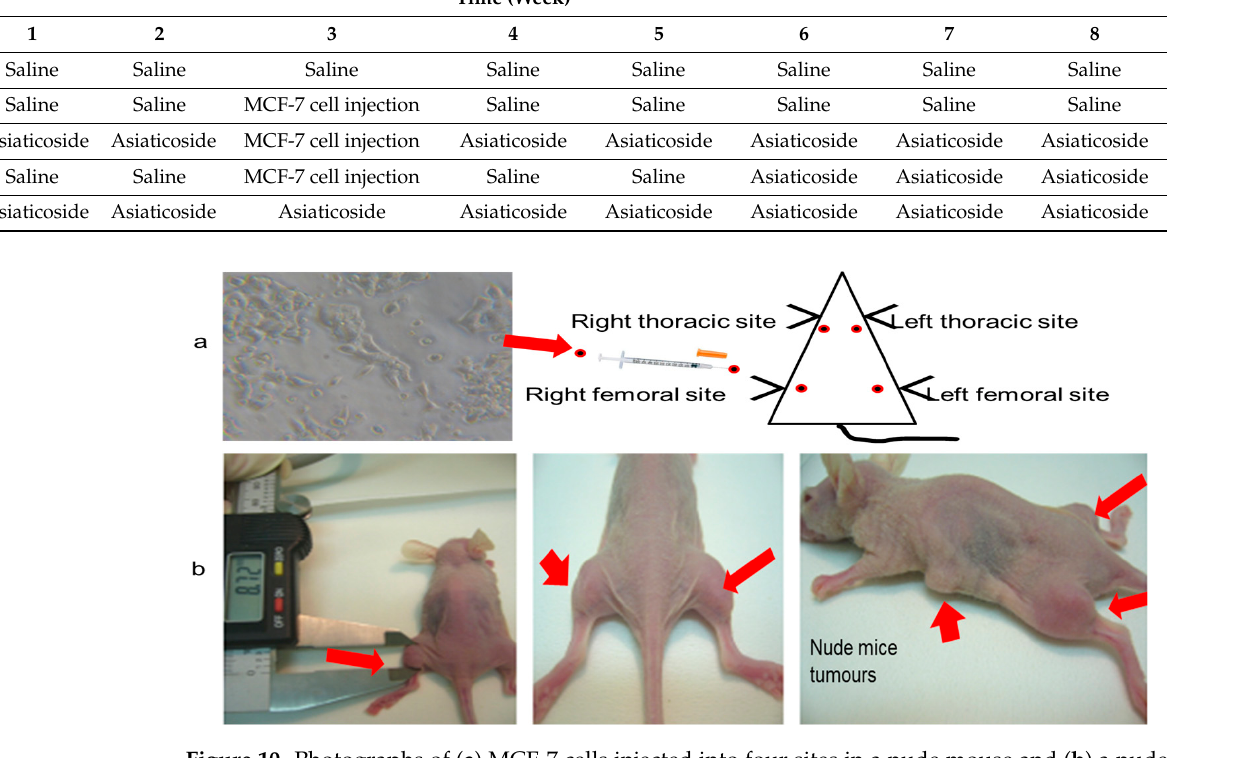
Figure 10. Photographs of ( a ) MCF-7 cells injected into four sites in a nude mouse and ( b ) a nude mouse and its palpable tumors (red arrows).